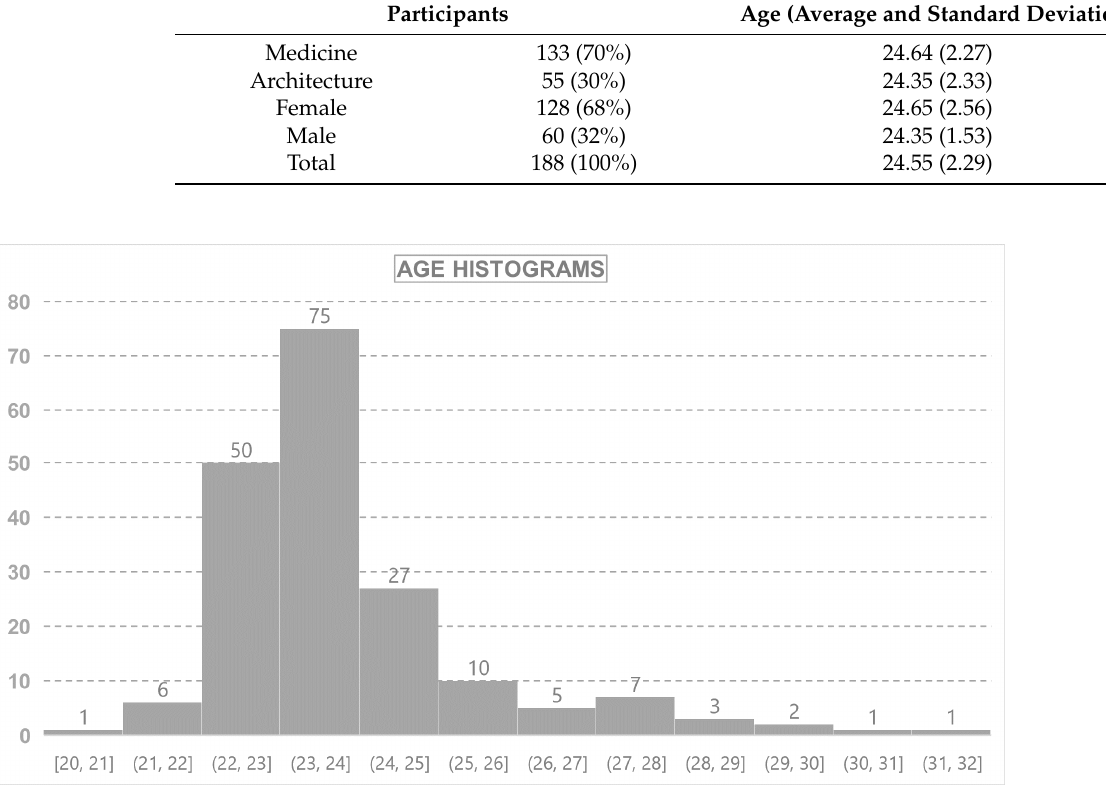
Figure 2. Age histograms.